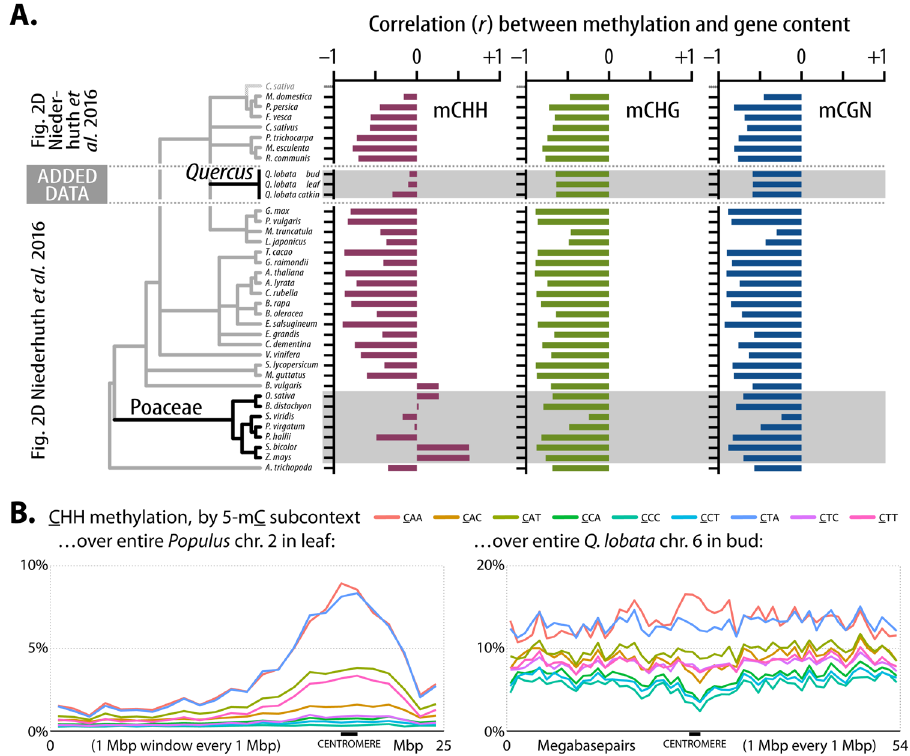
Fig. 6 DNA methylation across chromosomes. A Pearson correlation ( r ) between methylation level and the number of genes (100 kbp windows) for mCHH (left), mCHG (middle), and mCG (right) context levels from leaf tissue-based Fig. 2D of Niederhuth et al. 36 , inserting our data for three oak tissues (bud, leaf, and catkin from tree SW786, having matched analysis details as closely as possible). B Comparison of all nine DNA subcontext methylation levels within the CHH context over an illustrative chromosome of Popular trichocarpa 89 and Q. lobata (and see Fig. 5